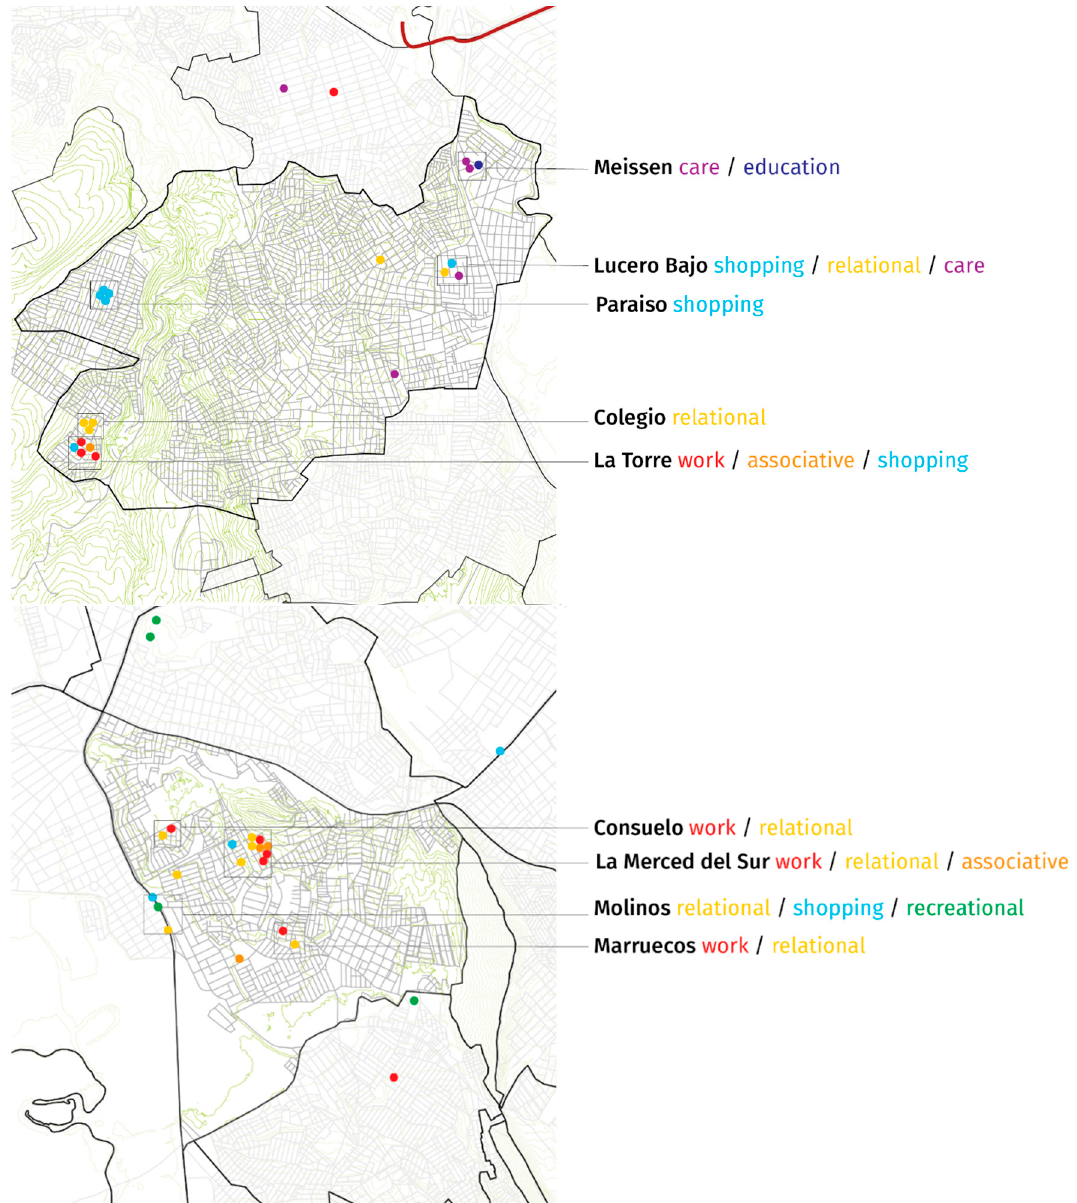
Figure 5. Locations and typologies of the activities at the neighbourhood scale, as mentioned in the interviews (source: [50]).